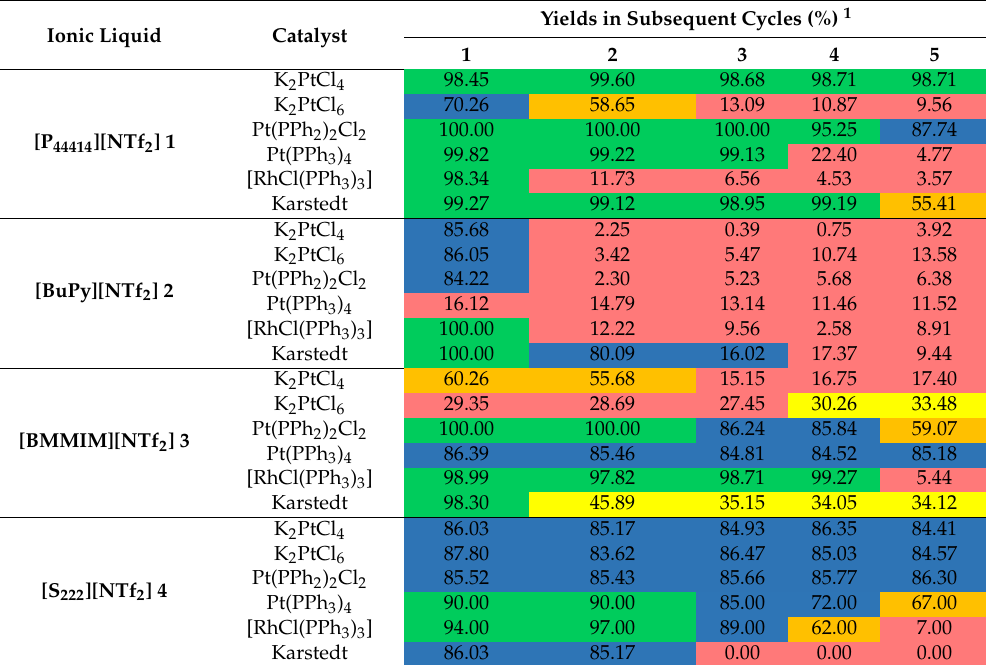
Table 1. Yields of hydrosilylation reaction in subsequent cycles for biphasic systems of ionic liquids and catalysts used. Ionic Liquid